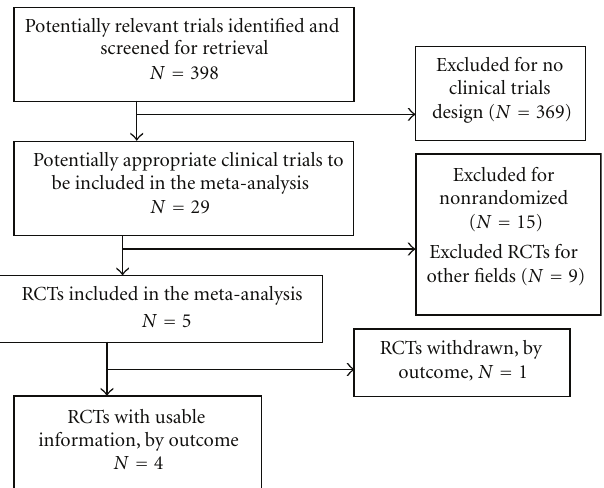
Figure 1: QUOROM flow diagram of included and excluded studies.